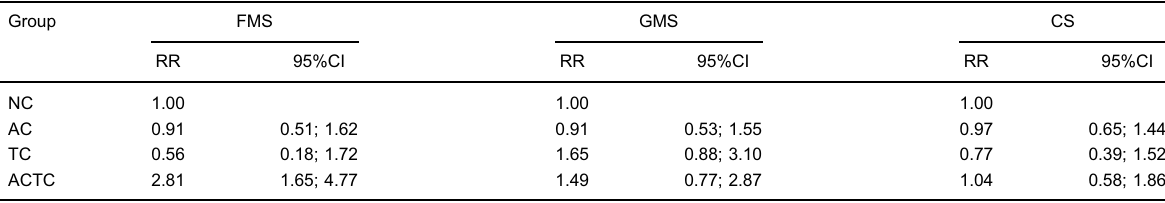
Model adjusted for maternal schooling and age, economic class, marital status, and depressive symptoms. NC: no consumption; AC: only alcohol consumption; TC: only tobacco consumption; ACTC: alcohol and tobacco consumption; FMS: Fine motor subscale; GMS: Gross motor subscale; CS: Cognitive